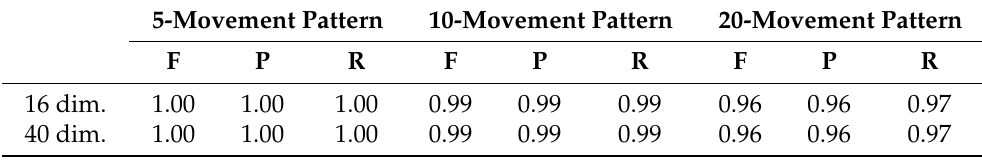
Table 1. Results for gaze movement pattern in Evaluation 1. (R: Recall, P: Precision, F: F-value).